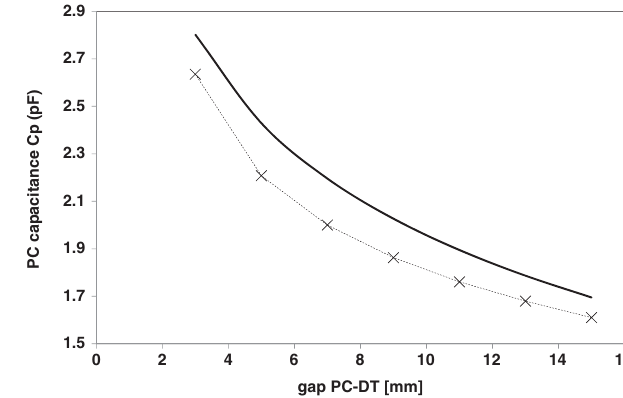
as a function of the gap PC-DT. The p formula, crosses are obtained from p